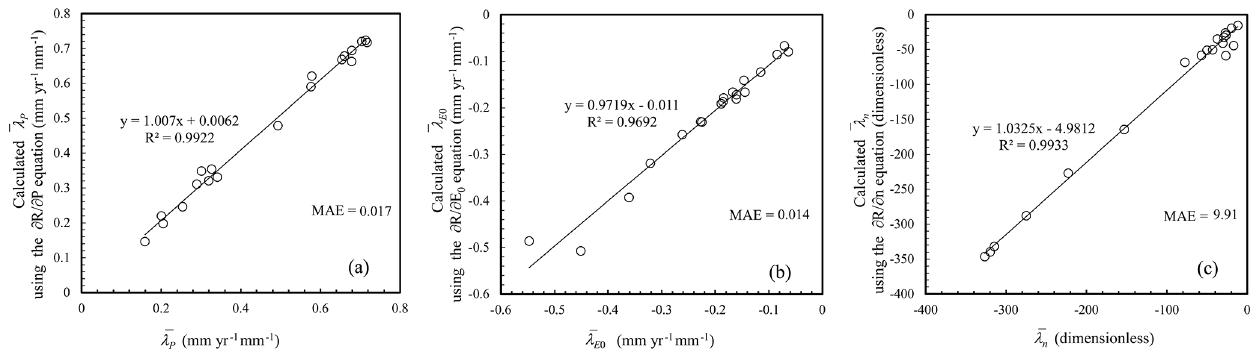
Figure 8. Performances of Eq. (2) to be used to predict λ P , λ E N (cid:80) | O i − P i | is the mean absolute error, where O and P are values that were actually encountered (given in Table S4) and MAE = N − 1 i = 1 predicted using Eq. (2), respectively, and N is the number of selected